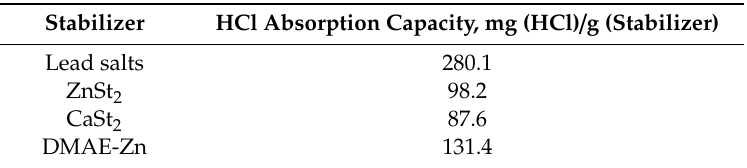
Table 1. The HCl absorption capacity of different thermal stabilizers for PVC. Stabilizer